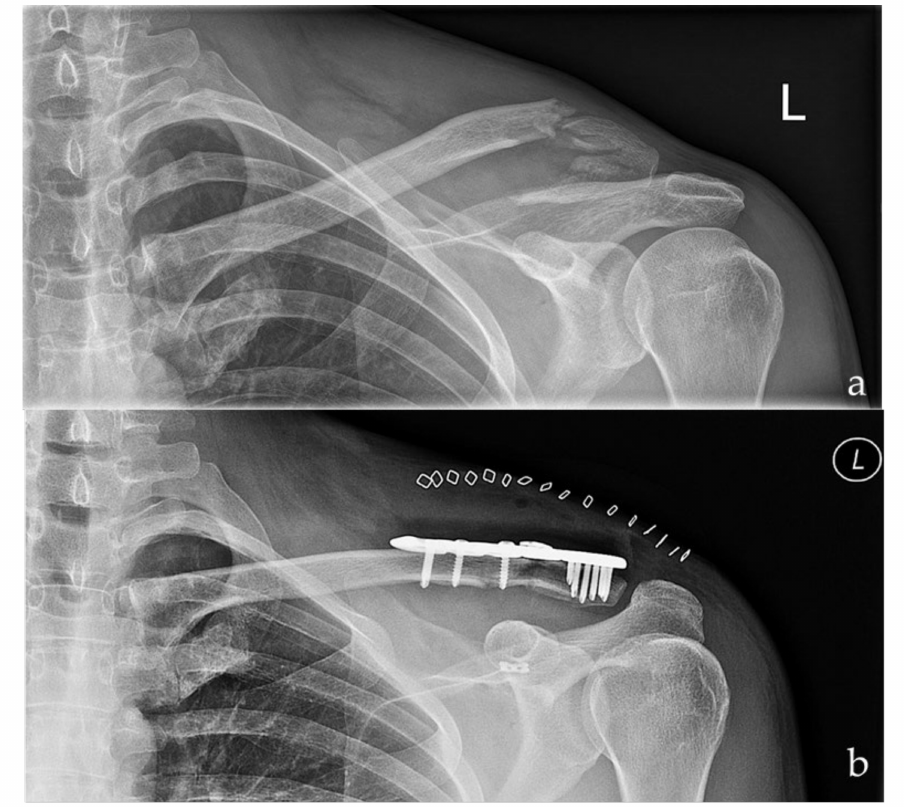
Figure 1. Preoperative ( a ) and postoperative ( b ) radiographs of a left sided multi-fragmentary, displaced lateral clavicle fracture (Neer IIb) after arthroscopic assisted fixation using a LCP and the knotted DogBone Technique (Group